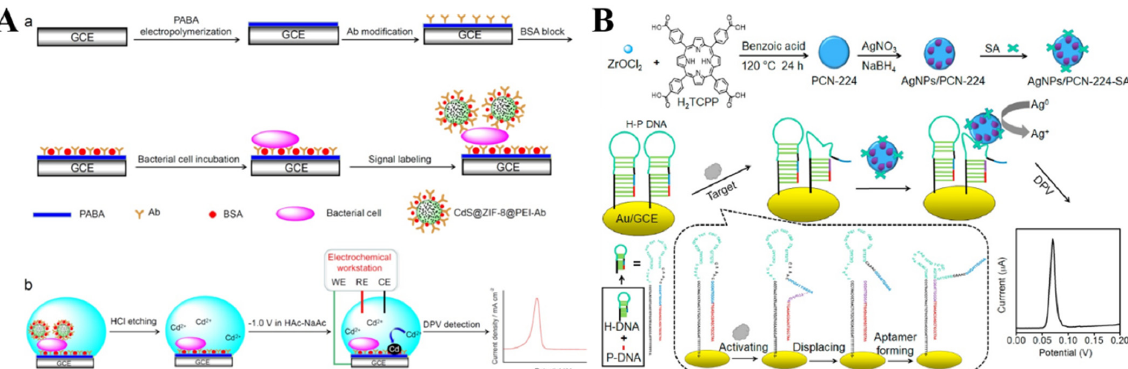
Figure 10. ( A ) Schematic illustration of (a) the fabrication steps of the sandwich − type electrochemical immunobiosensor for the detection of E. coli O157:H7 using CdS@ZIF-8 as signal tags. (b) Schematic illustration of the steps for DPV detection. Reprinted with permission from Ref. [222]. Copyright 2019, Elsevier. ( B ) Schematic illustration of the construction of an SA − modified AgNPs/PCN-224 probe and a direct electrochemical sensing strategy of telomerase activity via a conformation switch from aptamer-closed hairpin DNA to aptamer-on hairpin DNA. Reprinted with permission from Ref. [223]. Copyright 2021, Elsevier. Table 6. Detection performances of different electrochemical sensors, using MOFs as nanocarriers. Type of MOFs Analyte Linear Range LOD Ref.